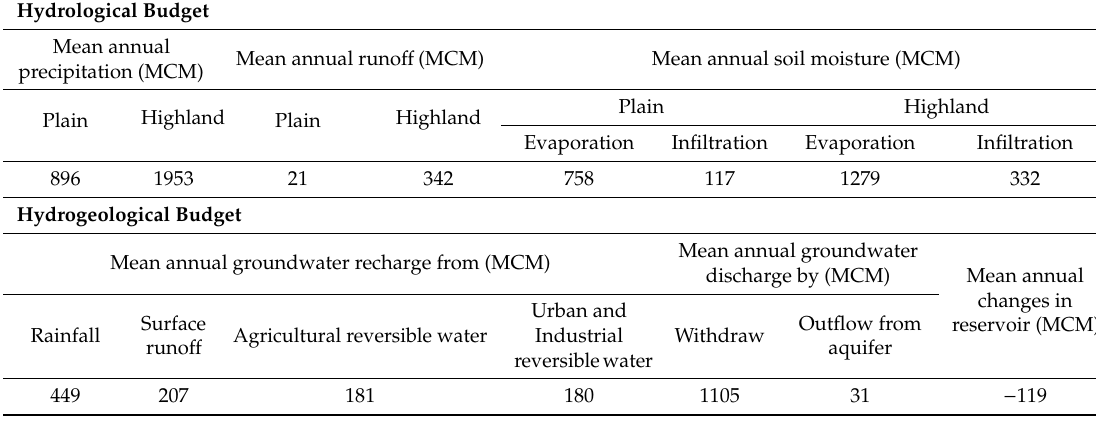
Table A1. Long-term hydrological and hydrogeological budget of the Kashafroud watershed [74–77]. Hydrological Budget